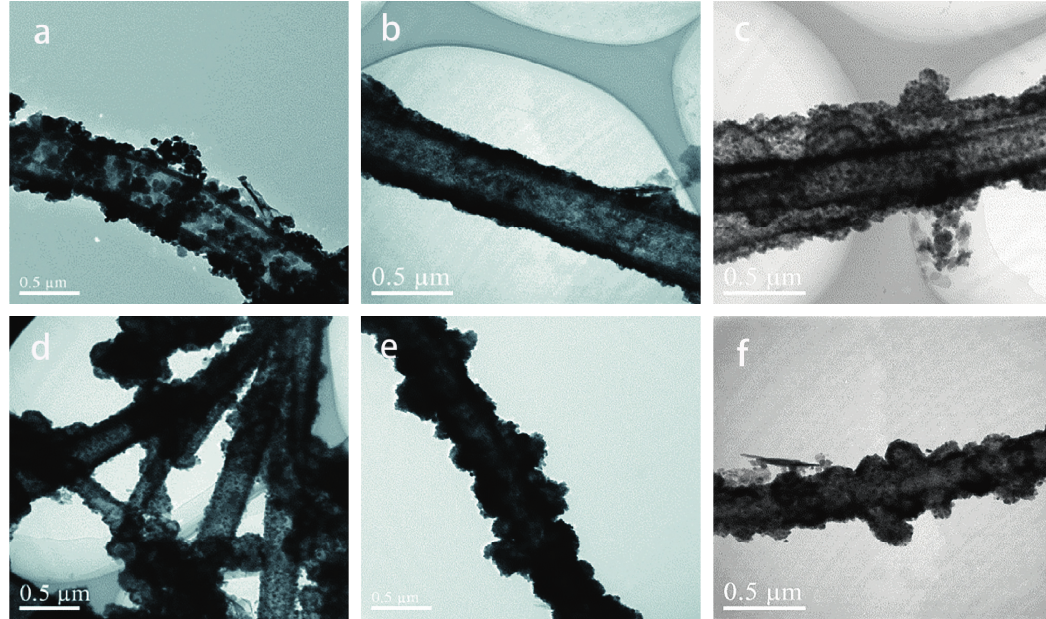
Figure 3: TEM pattern of S1 (a), S2 (b), S3 (c), S4 (d), S5 (e), and S6